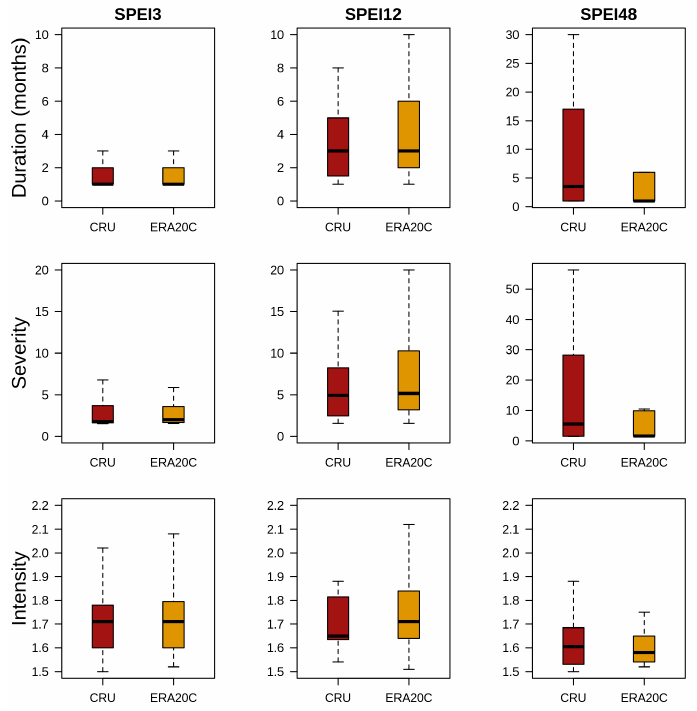
Figure 9. As in Figure 6, but for the CWSP region.